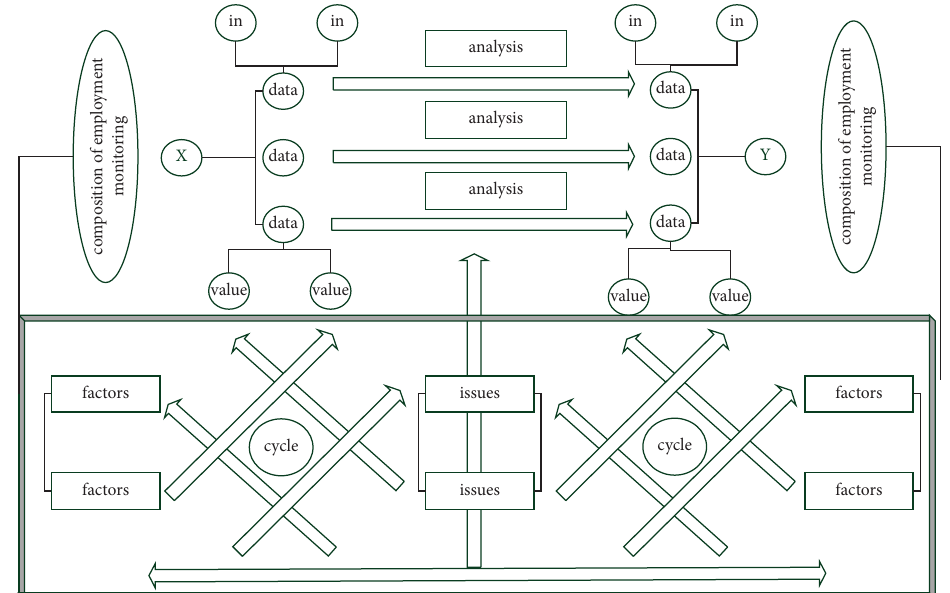
Figure 3: Hierarchical composition of employment